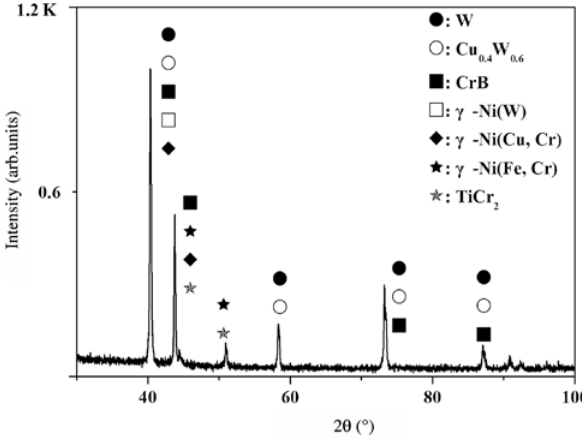
Figure 5: XRD patterns of the NiCrSiBFeTi brazed joint.